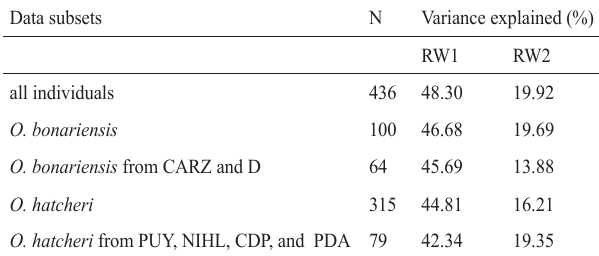
Fig. 3. Maximum likelihood phylogeny for 72 unique haplotypes obtained from O. hatcheri , O. bonariensis , and O. smitti . Haplotype labels indicate their sampling locality (as explained in Fig. 1 and Table 1) and the number of individuals (in parentheses). Several common haplotypes were recovered from several individuals from the same or different localities (most significantly haplotype 5). Monophyly of haplotypes from each species is supported by 100% bootstrap values, and two groups of O. hatcheri haplotypes (from EPU and CDP, indicated by heavier lines) also received strong bootstrap support. All other nodes were weakly supported by bootstrap analyses. *: presumptive hybrids individuals identified on meristic and morphological characters (Table Table 3. Interspecific and intraspecific morphological variation of Odontesthes species. Variance explained (%) by first and second RW is indicated. N: number of specimens.